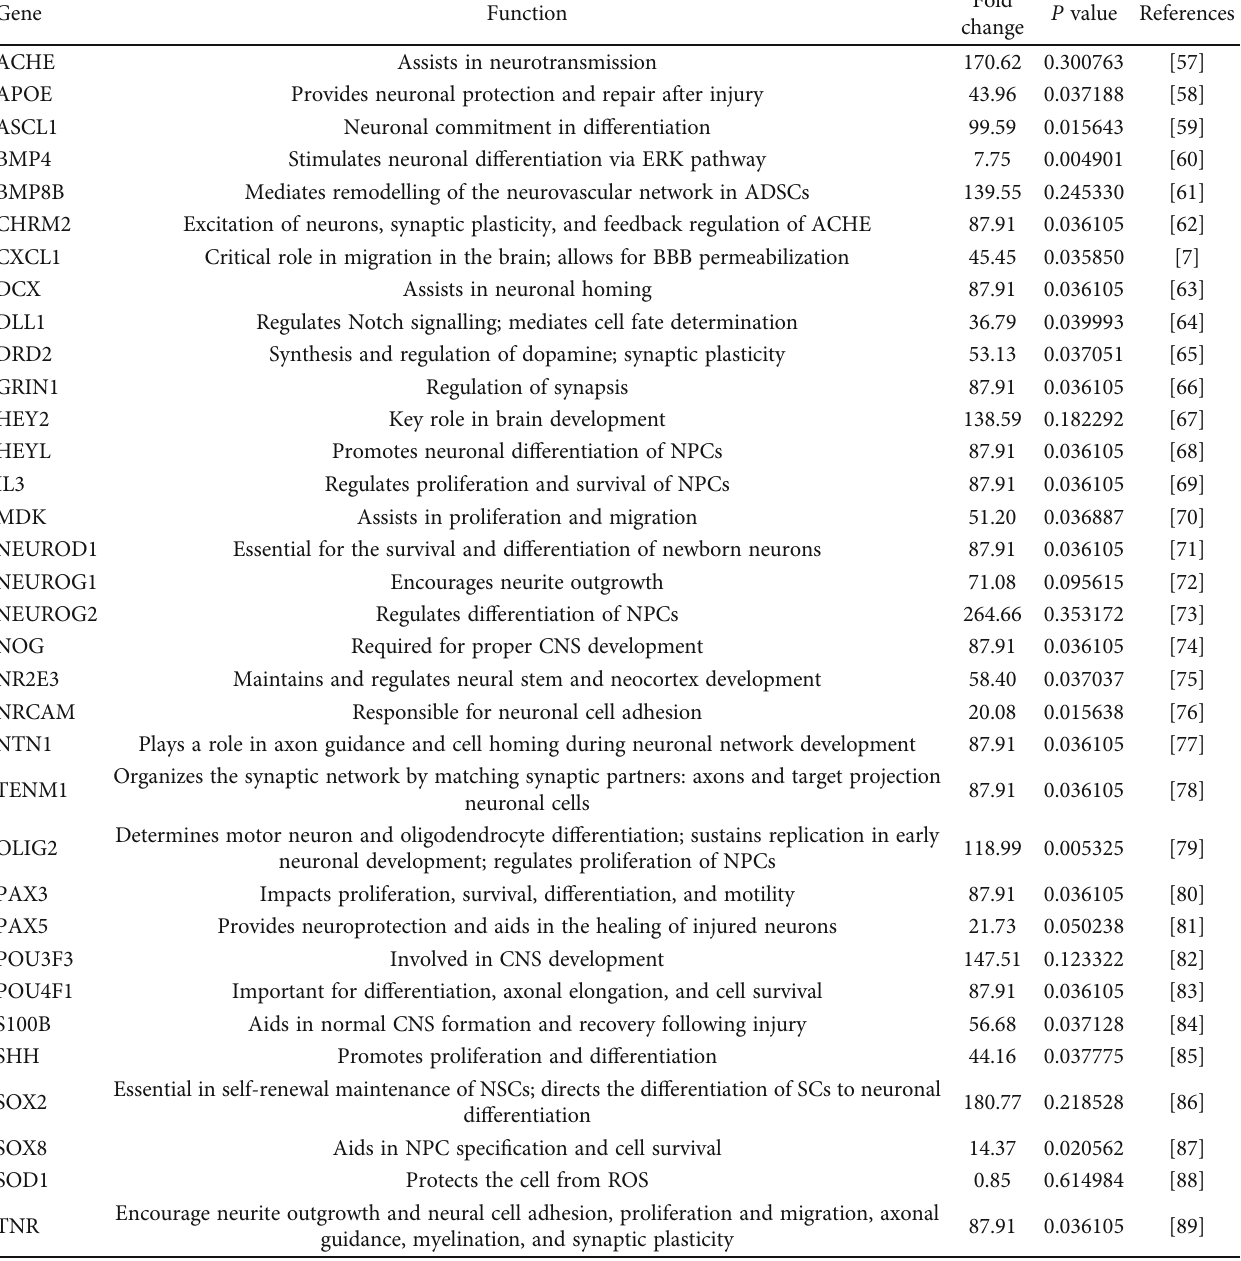
Table 2: Genes and transcription factors related to neurogenesis detected through RT-PCR following IT2 NIR-G PBM treatment with their relevant functions, fold change, and P